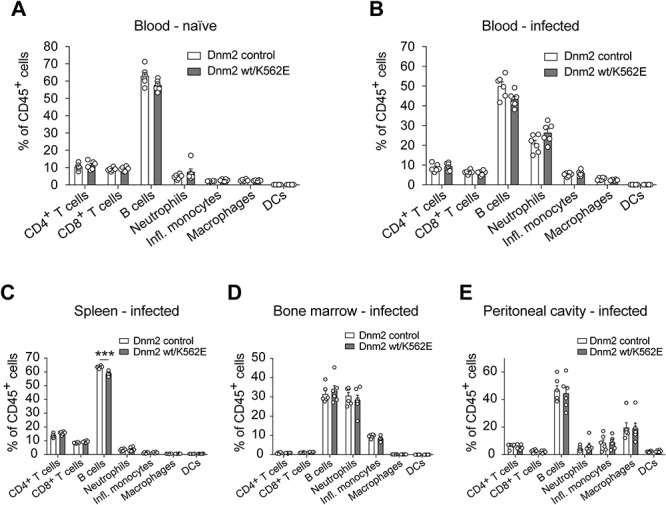
Dnm2 wt/K562E mice do not reproduce obvious signs of neutropenia as reported in some human patients carrying the same mutation. (A–E) Analysis of the relative abundance of immune cells (CD4+ T cells, CD8+ T cells, B cells, neutrophils, inflammatory monocytes, macrophages, dendritic cells) between control and Dnm2 wt/K562E mice at 12 weeks of age, both in blood samples of naïve mice (A) and of mice infected with Listeria monocytogenes (B), reveals no major changes between genotypes for each cell type. Analysis of the same cell types in spleen (C), bone marrow (D) and peritoneal cavity (E) of infected control and infected Dnm2 wt/K562E animals consistently reveals no major alterations between both genotypes for each cell type. Bar heights, mean; error bars, SEM (n = 6 mice/genotype). Two-tailed unpaired Student’s t-test with Holm–Sidak’s multiple comparisons test. Significance was set at ***P < 0.001.